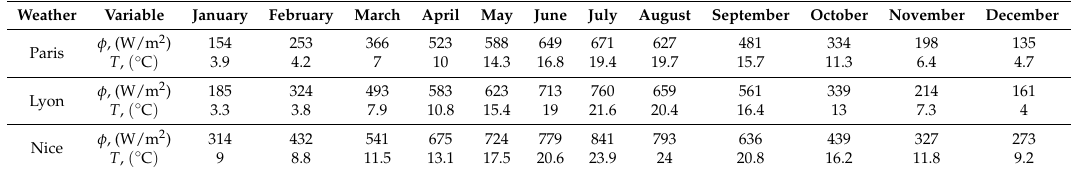
Table 1. Meteorological parameters for Paris-Orly, Lyon and Nice (France).